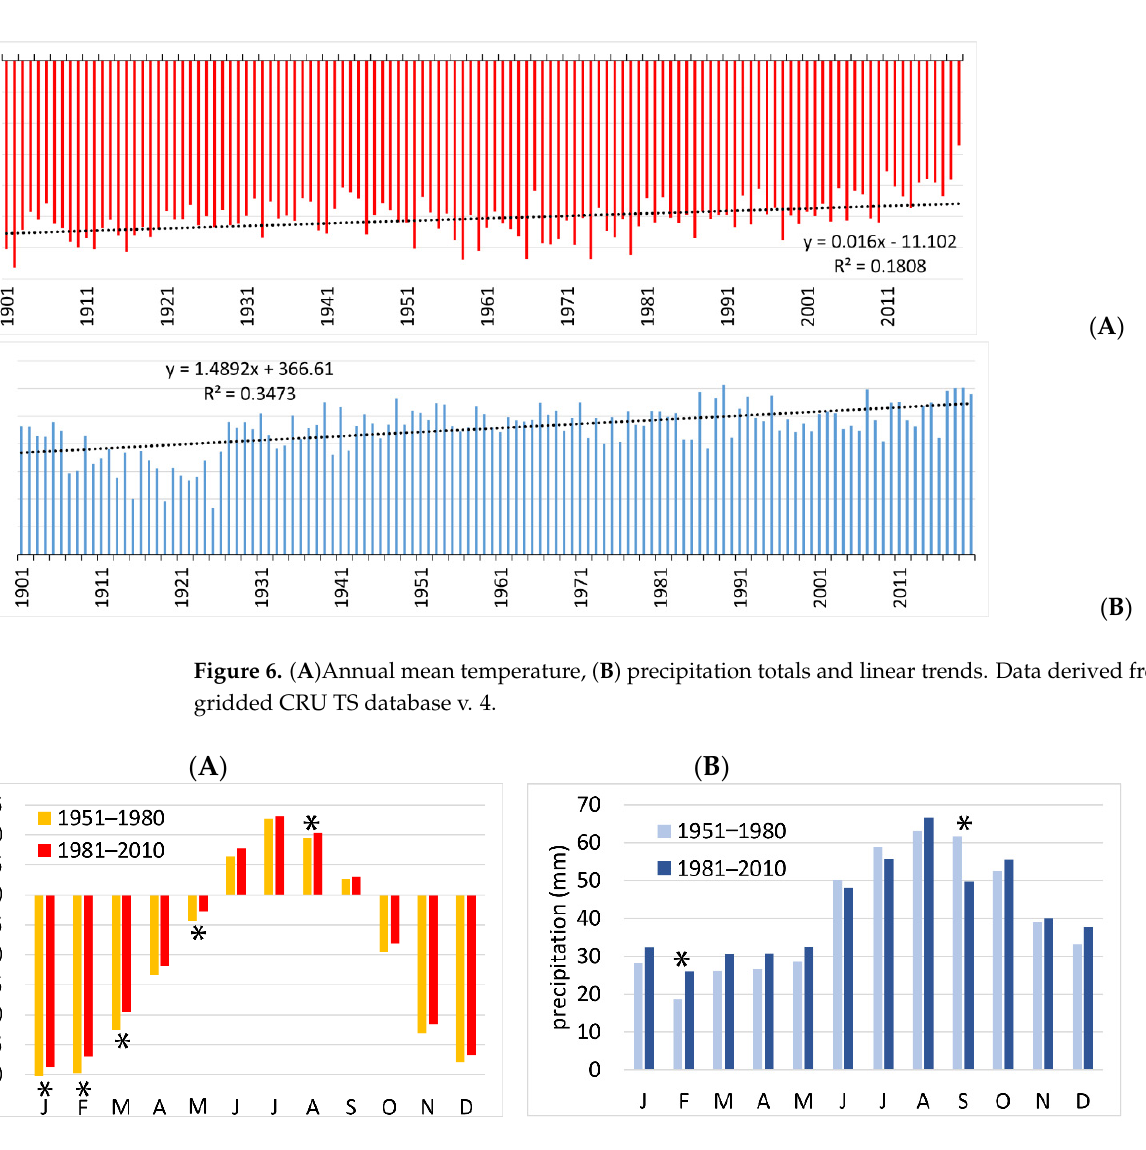
Figure 7. ( A ) Average monthly temperature and ( B ) precipitation totals for WMO standard periods 1951–1980 (light) and 1981–2010 (dark). Statistically significant difference ( p < 0.05) is denoted by asterix (*).